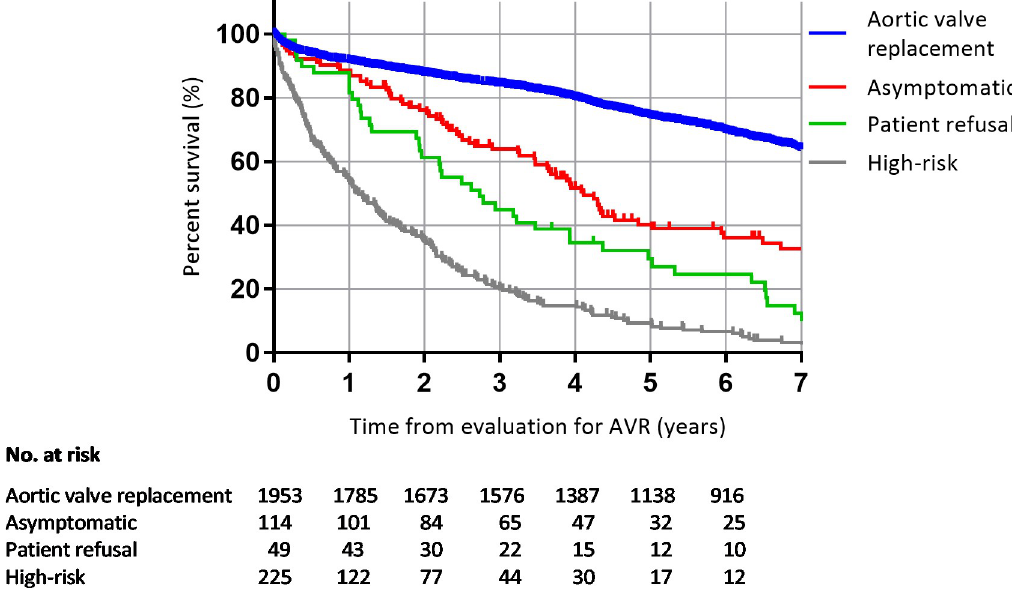
Fig 2. Survival analysis. Kaplan-Meier curve reflecting survival in patients with severe aortic stenosis dependent on treatment allocation.